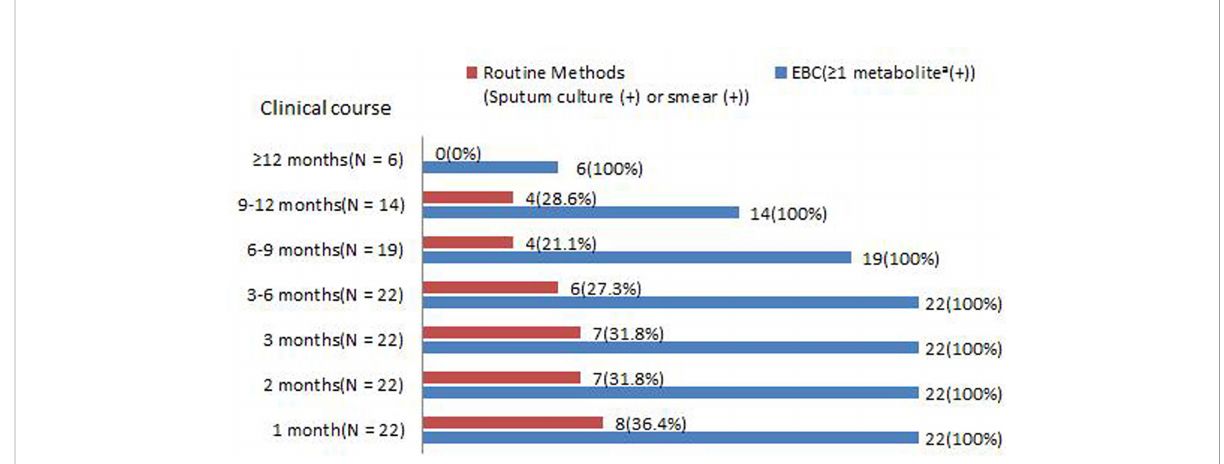
FIGURE 6 Positive rates of (sputum culture and smear) and ≥ 1 metabolite in EBC samples among PA patients during antifungal therapy. a Asperpyrone C, Kotanin, Terphenyllin, Terrelumamide B, and Cyclotryprostatin